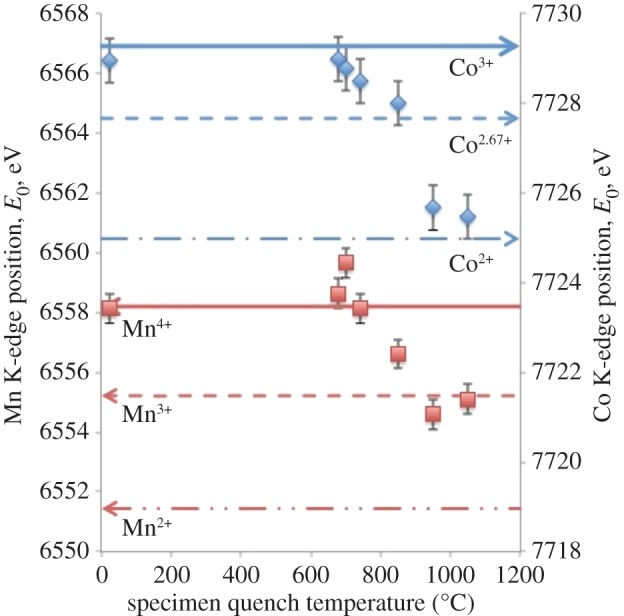
Determination of average Mn and Co valence states from XANES data of as-prepared and quenched LiCoMnO4 using calibration peak maximum values measured from standard materials: C4H6Mn2+O4.4H2O (red dotted dashed line), Mn3+2O3 (red dashes) and Mn4+O2 (red solid line), Co2+O (blue dotted dashed line), Co2.67+3O4 (blue dashes) and LiCo3+O2 (blue solid line).